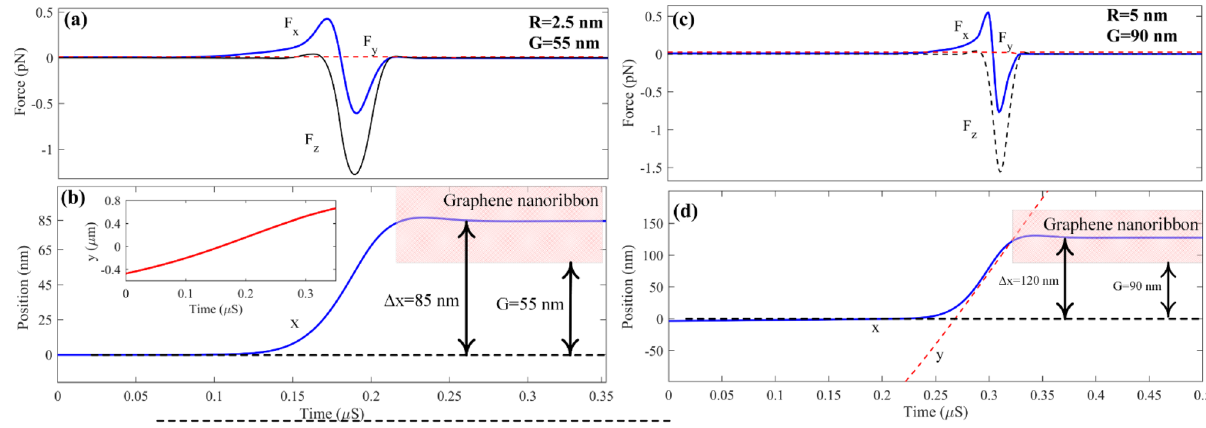
Figure 11. Force and position versus time for nanoparticles with ( a ) and ( b ) R = 2.5 nm and G = 55 nm and ( c ), ( d ) R = 5 nm and G = 90